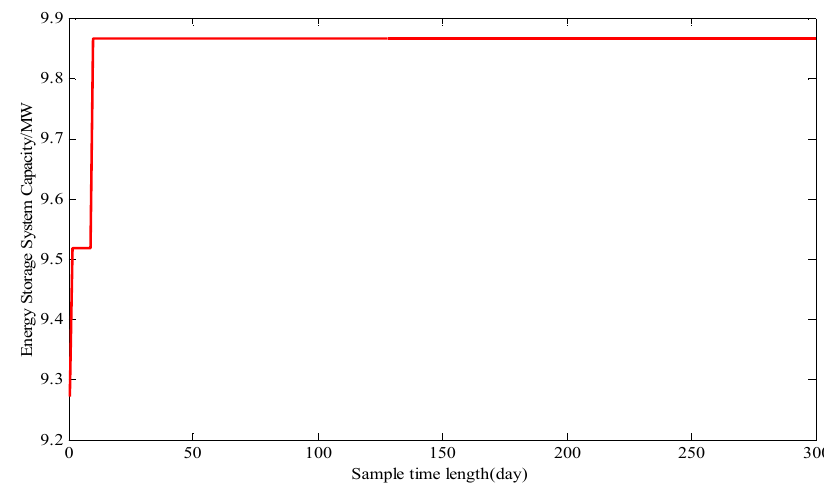
Figure 8. The relationship between the required capacity of energy storage systems and sampling time length.